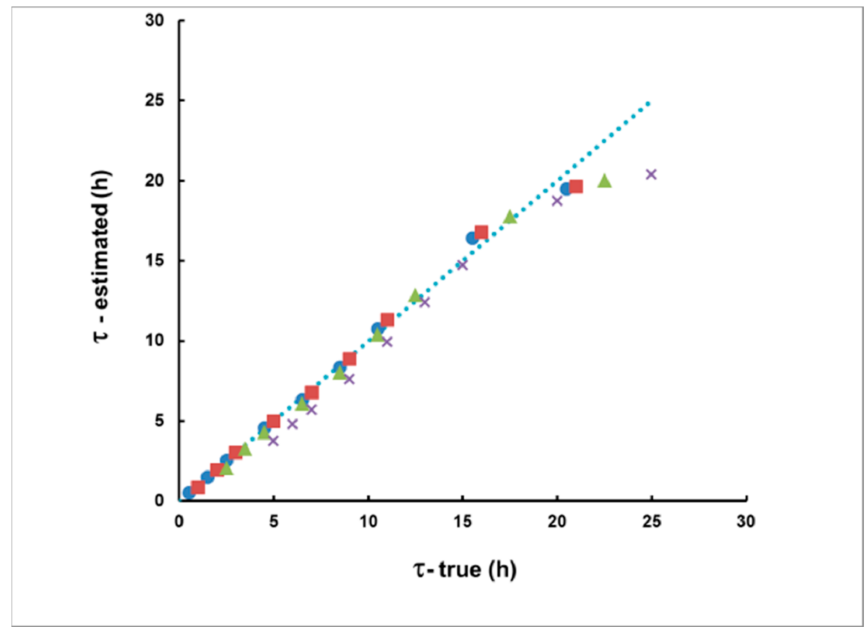
Figure 7. The estimated, according to S 1 /S 2 delay, compared with the true delay of rectangular plumes of duration 1 h ( • ), 2 h ( (cid:4) ), 5 h ( (cid:78) ) and 10 h ( × ). The dotted line represents the coincidence between the estimated and true values.